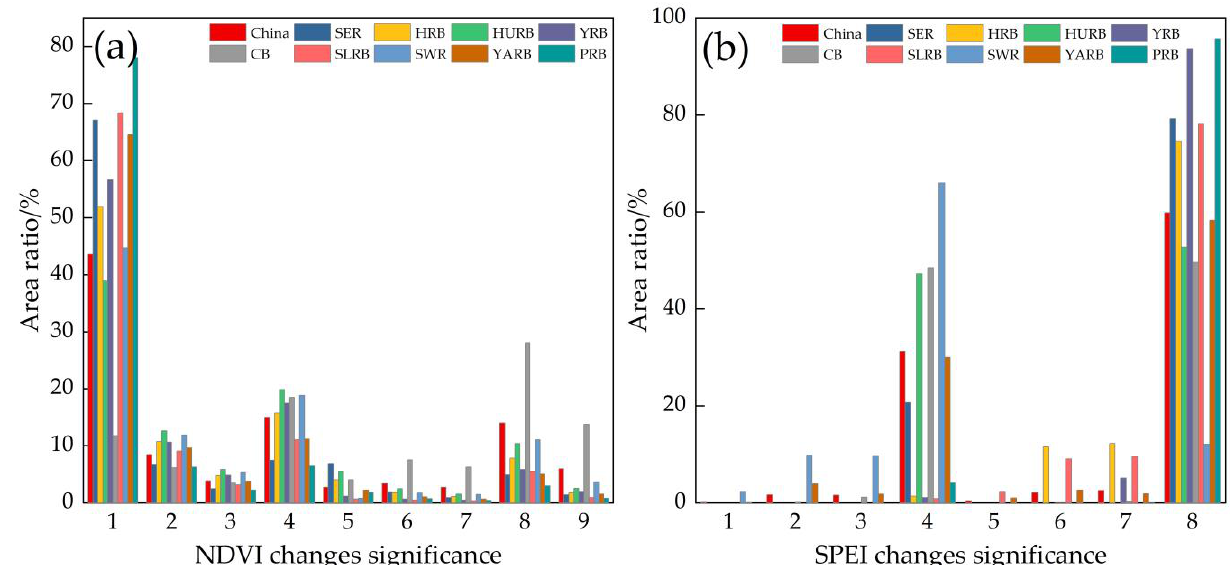
Figure 4. Significance analysis of changes in the ( a ) NDVI and ( b ) SPEI in China and its nine river basins from 1998‒2017. YARB — Yangtze River Basin, YRB — Yellow River Basin, PRB — Pearl River Basin, SWR — Southwest Rivers, SER — Southeast Rivers, HRB — Haihe River Basin, HURB — Huaihe River Basin, SLRB — Songhua and Liaohe River Basin, CB — Continental Basin.